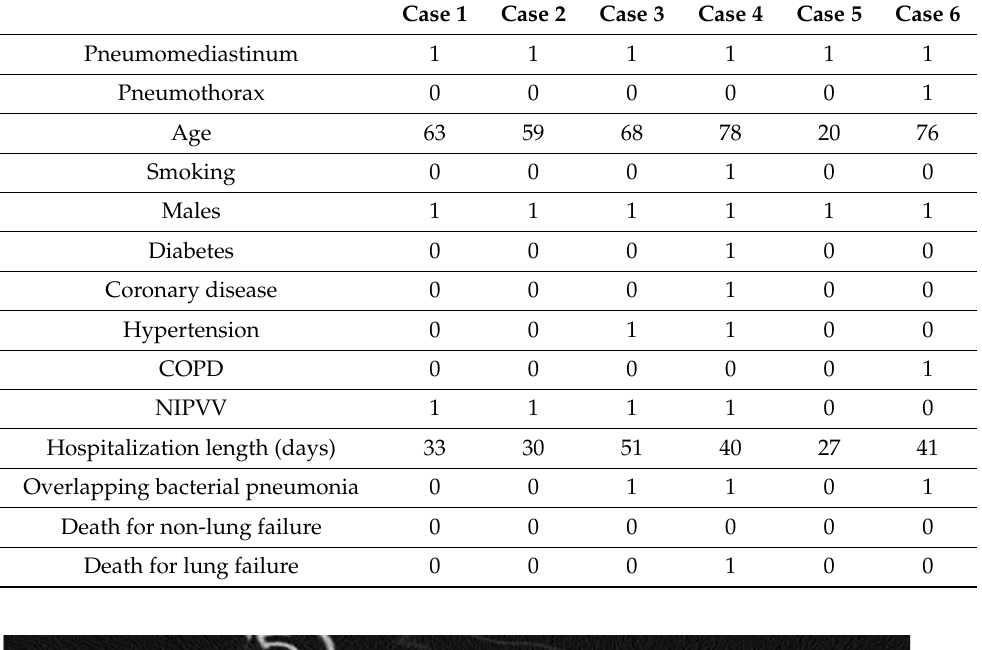
Table 1. Clinical characteristics of observed patients with pneumomediastinum and pneumothorax.